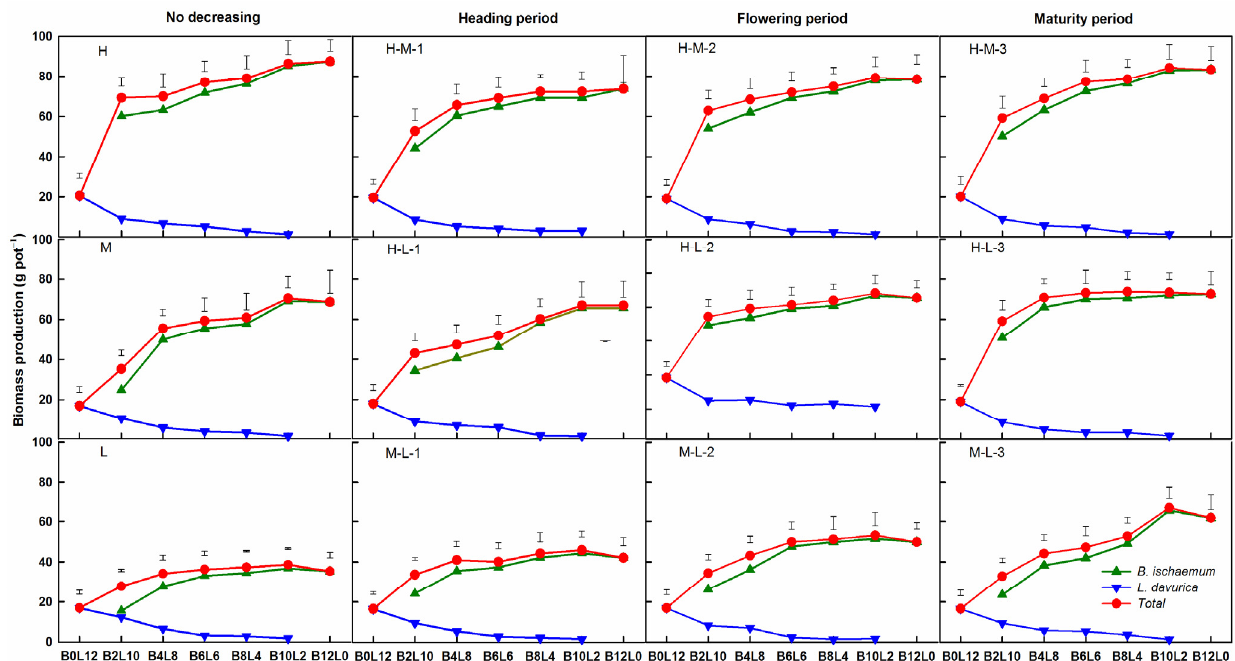
Figure 2. Total biomass production of B. ischaemum (B) and L. davurica (L) mixtures under soil water decreasing treatments. Vertical bars represent LSD 0.05 values.